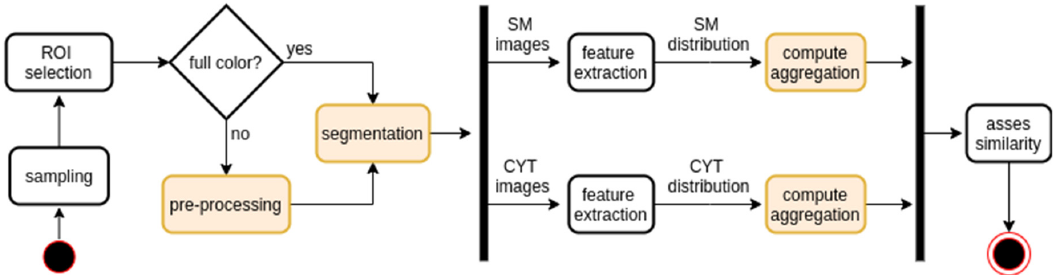
Figure 4. General workflow used in the quantitative differential analysis. Steps reported within highlighted boxes are optional. A sampling of the images in the dataset is carried out as the first step. Next, the ROI is defined based on the type of the analysis (global or local); then, depending on the specific selected feature, a preprocessing step and a segmentation step may follow. For each technique and each image, a feature is extracted. The result is an empirical distribution: statistical descriptors are computed to assess the similarities/differences between SM and CYT.